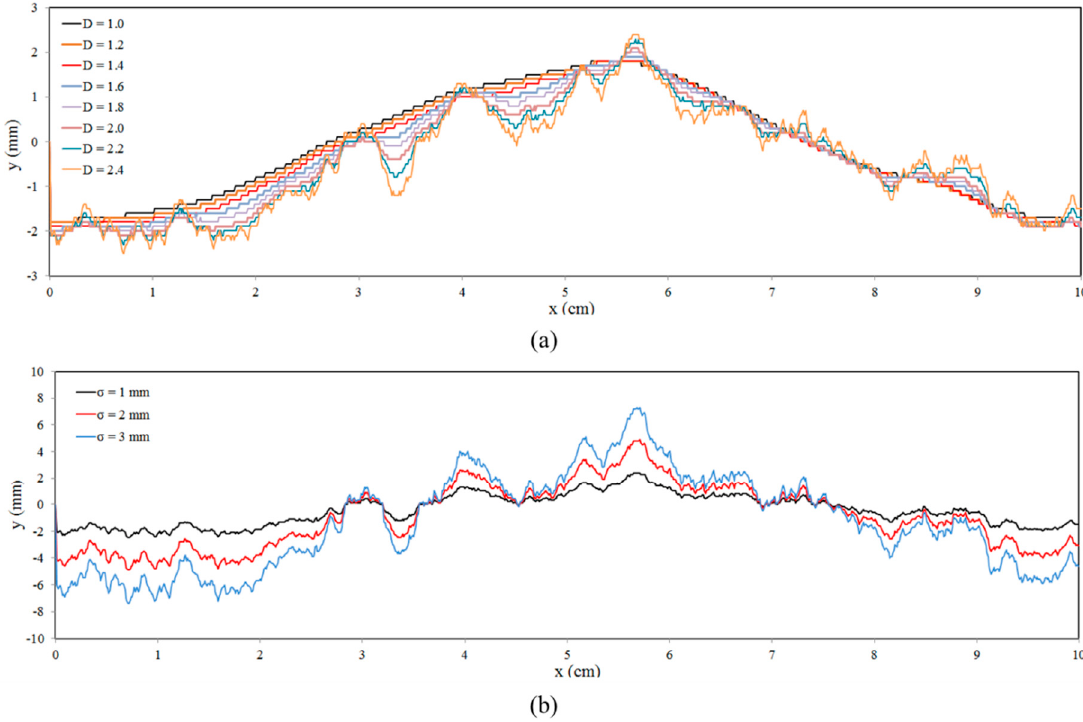
Figure 2. Profiles for synthetic fractures with different fractal dimensions and standard deviations: (a) profiles of different fractal dimensions with standard deviations of 1 mm; (b) profiles with different standard deviations at a fractal dimension of 2.4.